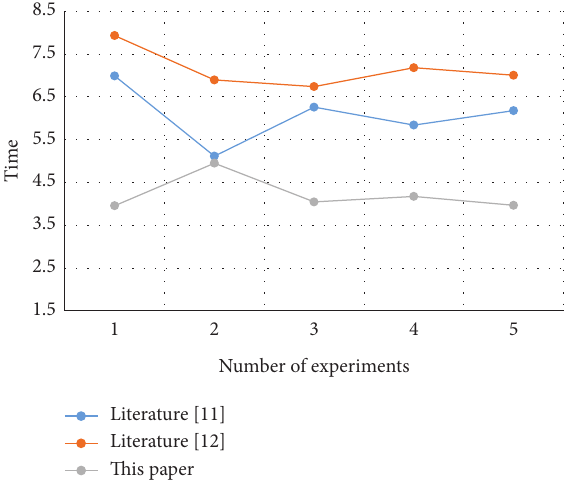
Figure 6: Time of noise-removed music signals. Figure 7: Time of noisy music